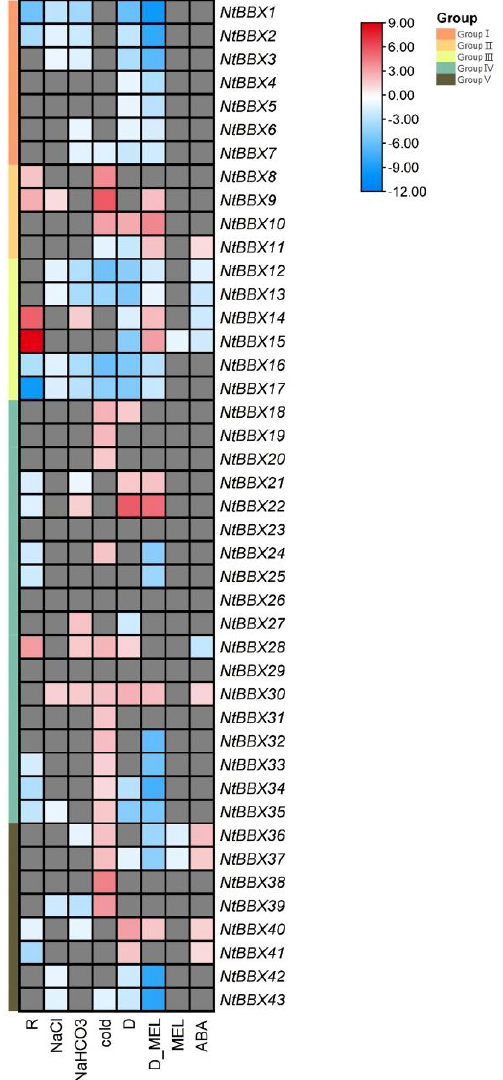
Figure 10. Differential expression under multiple stresses and hormone treatment. The red boxes, blue boxes and gray boxes represent significant up-regulation, significant down-regulation and no significant change for NtBBX genes under corresponding conditions, respectively. The color depth of red boxes and blue boxes represents the size of log 2 fold change.